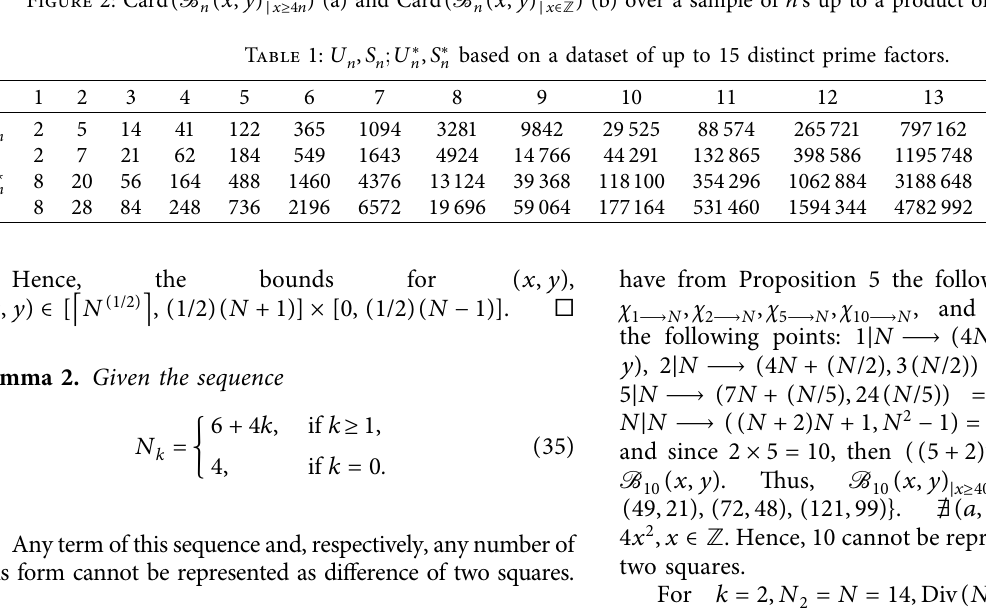
Figure 2: Card ( B